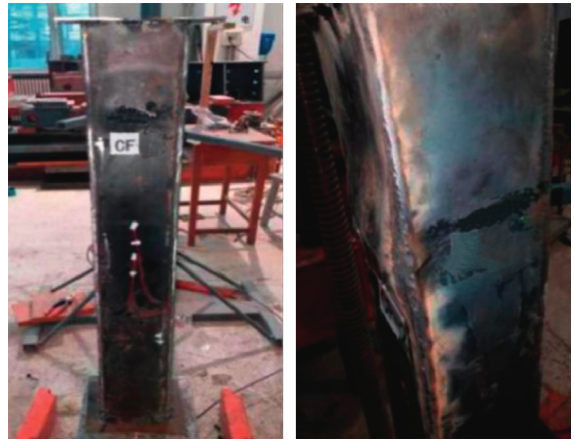
Figure 21: CF-2 failure mode.